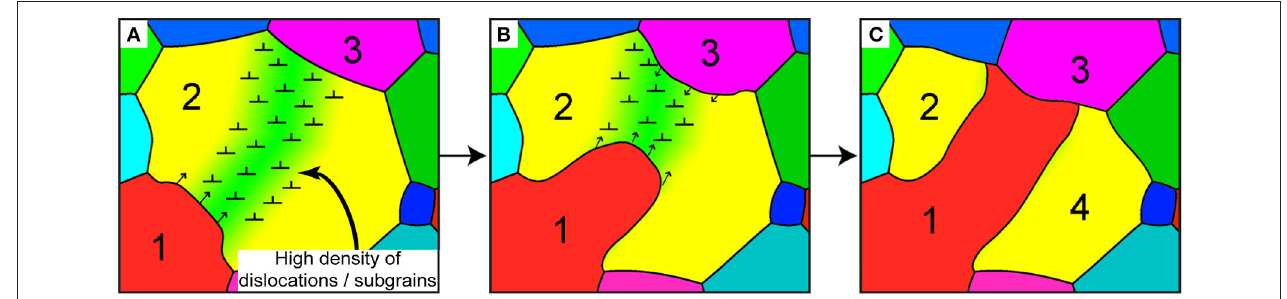
FIGURE 1 | Schematic illustration of the grain dissection process according to Means (1983) and Urai (1983). (A) A bulge of grain 1 is migrating into a high dislocation-density area to reduce locally high strain energies in grain 2. (B) The bulge of grain 1 is migrating further through the high strain-energy area of grain 2. (C) The bulge ultimately reaches grain 3, dividing grain 2 into two grains. Bulging stops due to low energy gradients and driving forces between grain 1 and 3. The new grain 4 and grain 2 are characterized by a similar lattice orientation; an orientation family.